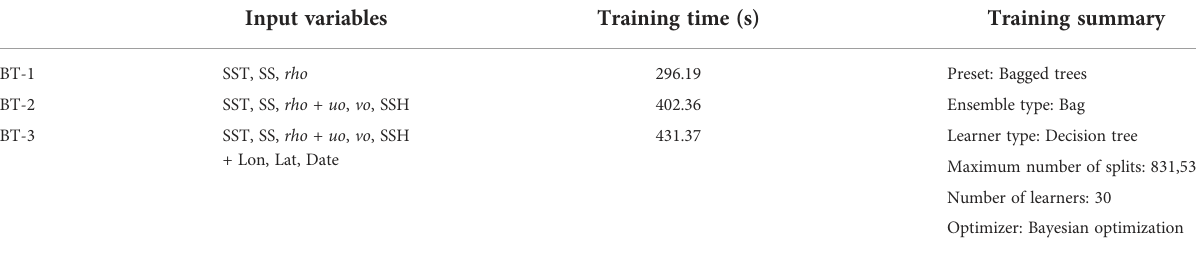
TABLE 2 Summary of machine learning models for estimating Sargassum distribution from environmental